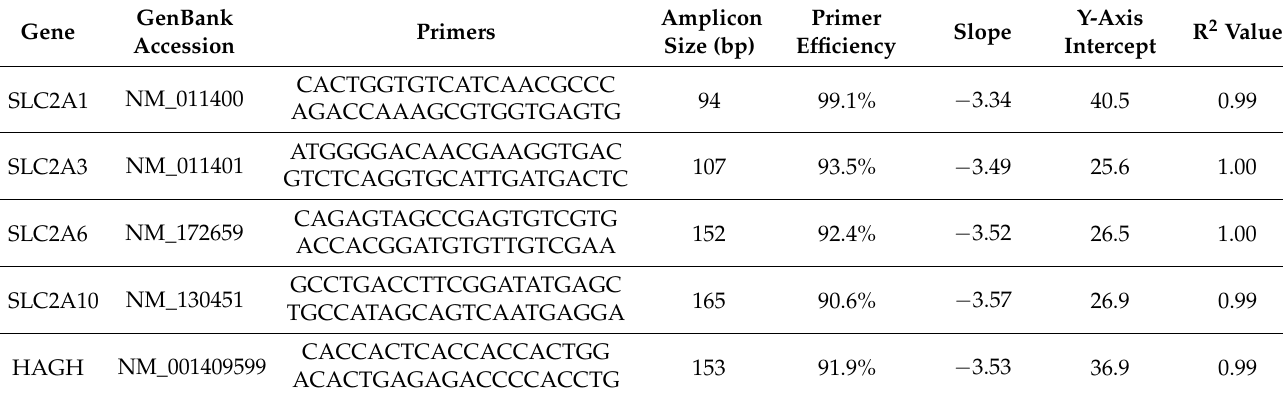
Table 1. RT-qPCR primer sequence, specificity, and efficiency